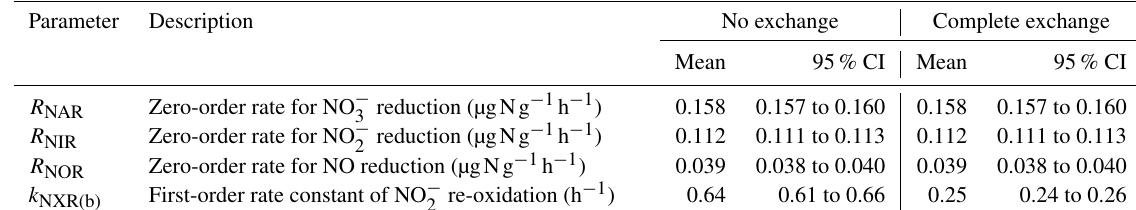
Table 1. Means and 95% confidence intervals of modeled denitrification rates and NO − and complete-exchange scenarios.